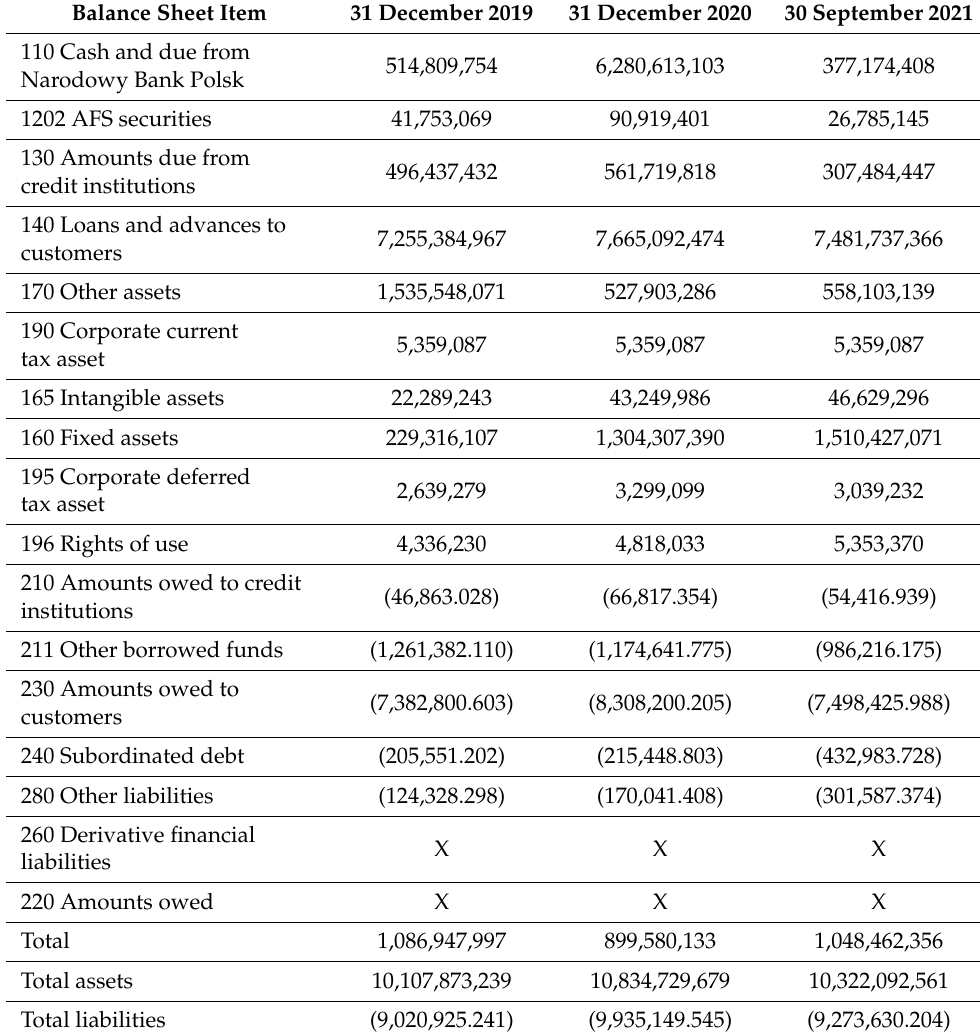
Table 2. Turnover balance sheet of bank assets and